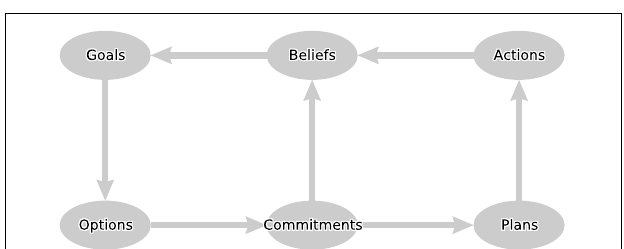
FIGURE 3 |The domino agent framework, an enhanced BDI agent